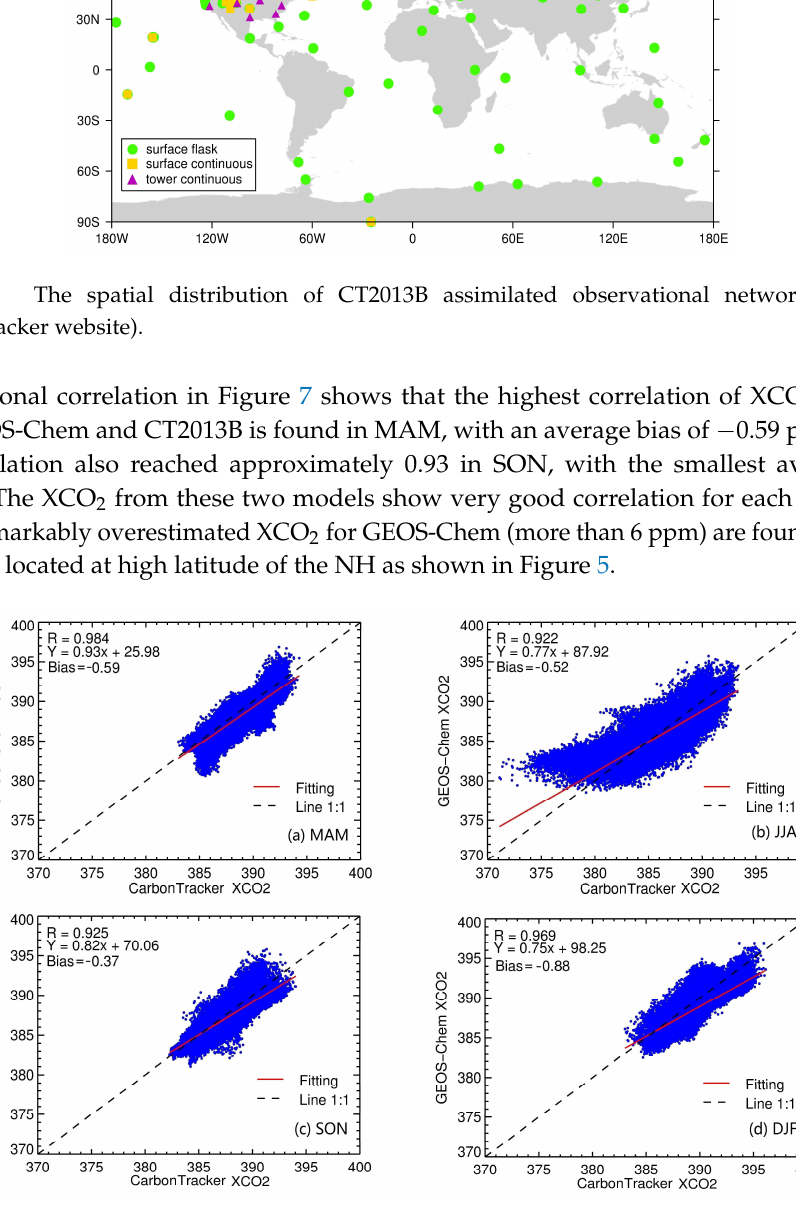
Figure 7. Scatter plots of XCO 2 from CarbonTracker (CT2013B) versus that of GEOS-Chem during March 2010–February 2011. ( a )–( d ) indicate MAM, JJA, SON and DJF respectively. Unit: ppm.